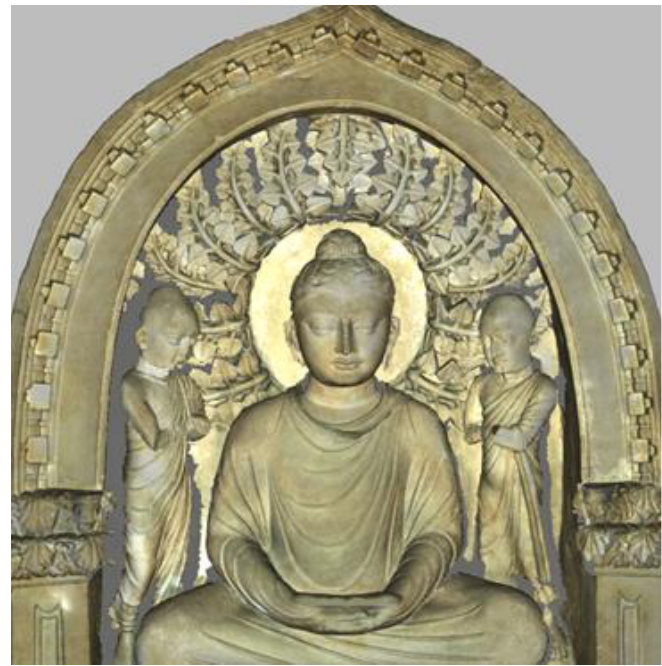
Figure 11. Incomplete 3D scan of the “Buddha” statue.